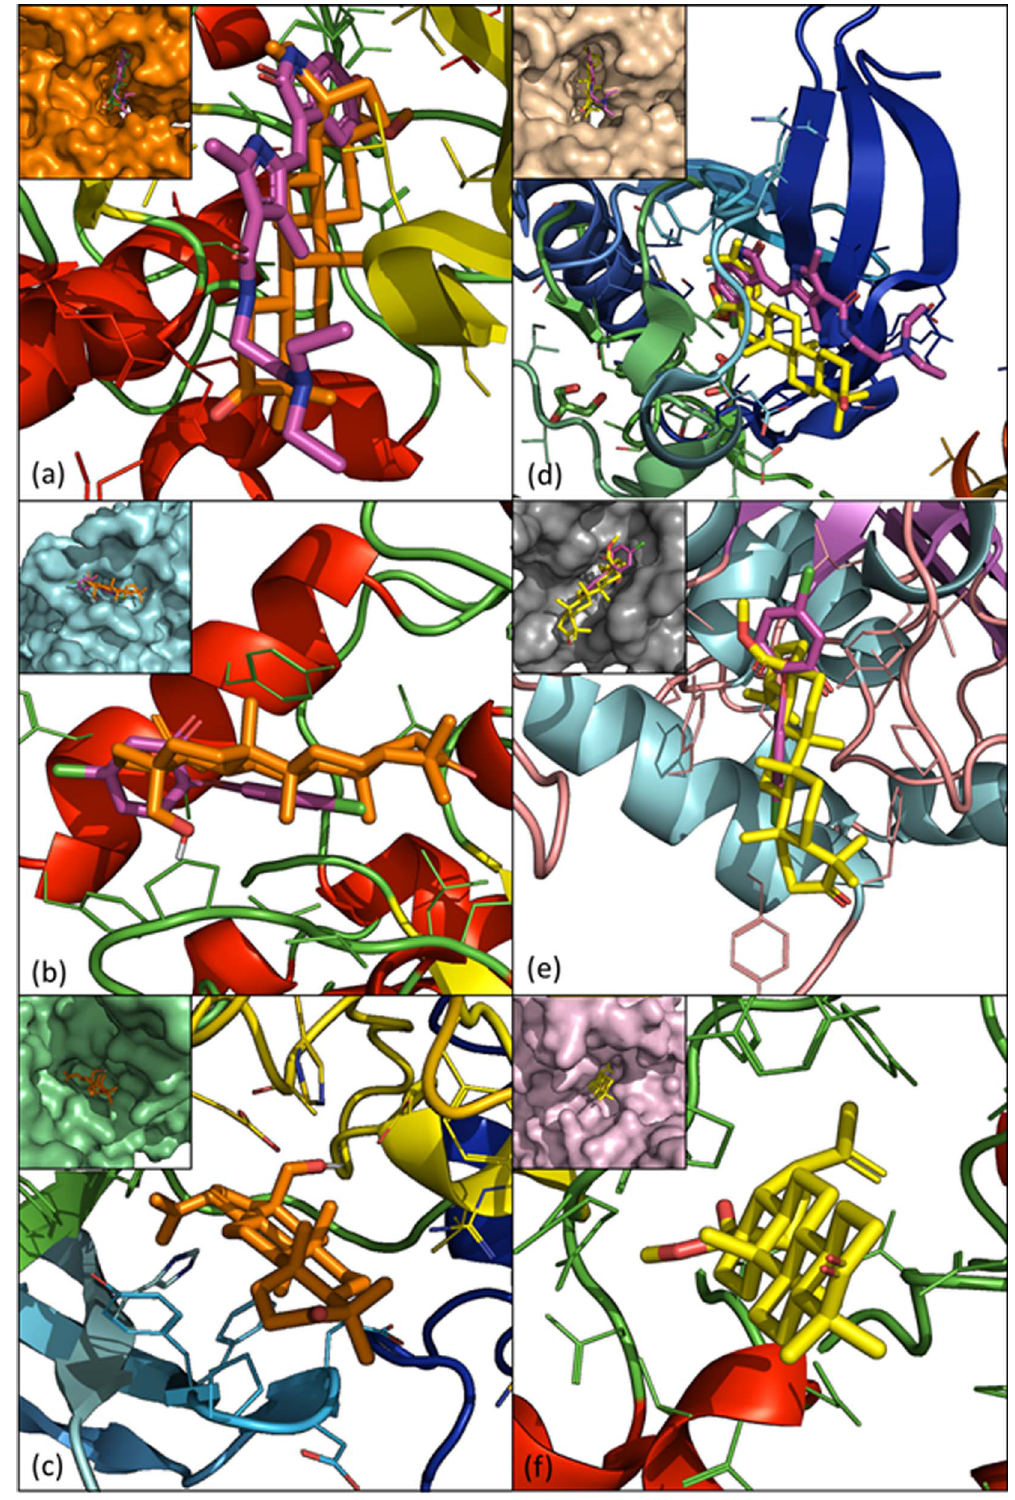
Figure 3. PyMol visualization of PDB ID 3HZT (CDPK3), 2O50 (ENR), and 3BYV (ROP8). (a) 3HZT with betulone (orange) and co- crystallized ligand (PDB ID J60, pink). (b) 2O50 with betulone (orange) and triclosan (pink). (c) 3BYV with betulone (orange). (d) 3HZT with BAME (yellow) and co-crystallized ligand (PDB ID J60, pink). (e) 2O50 with BAME (yellow) and triclosan (pink). (f) 3BYV with BAME (yellow). The inserts of each panel are the co-location of ligands and known inhibitors (if available) in the pockets